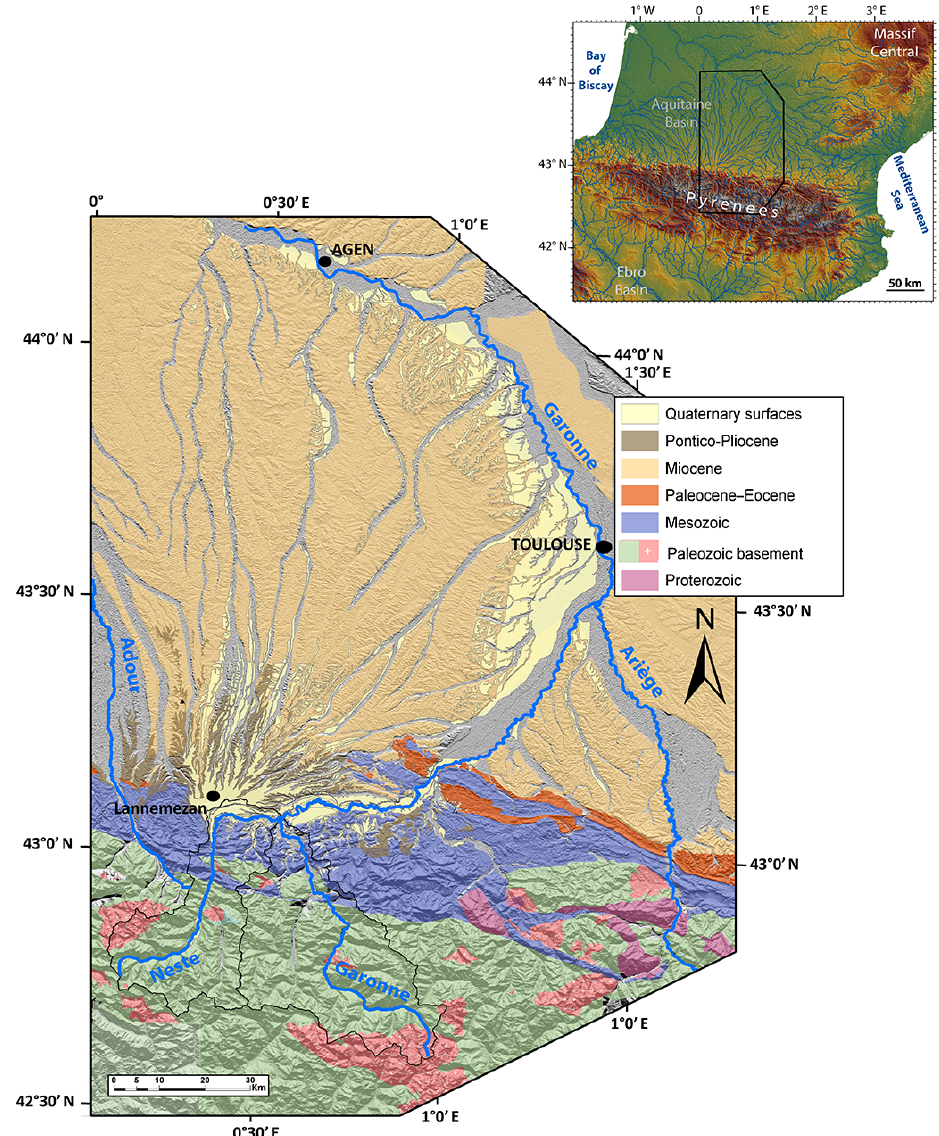
Figure 1. The Lannemezan megafan and Neste catchment in the central northern Pyrenees (inset map shows location in southern